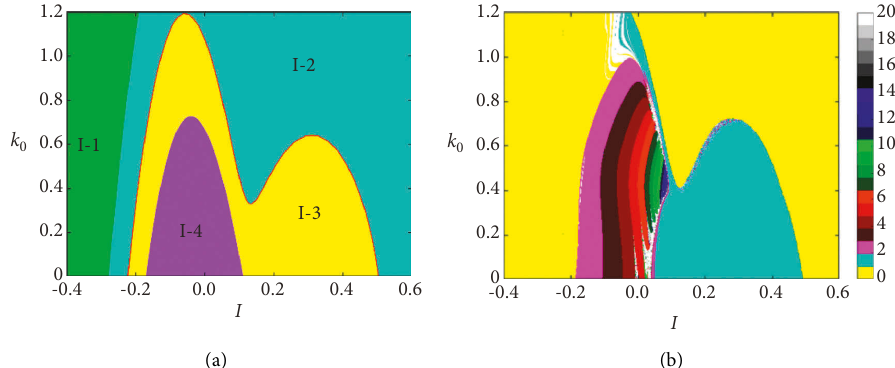
Figure 1: The local dynamics and global response of system (1) for I ∈ [− 0 . 4 , 0 . 6 ] , k (b) Bifurcation diagram, where diverse discharge modes are identified by different color